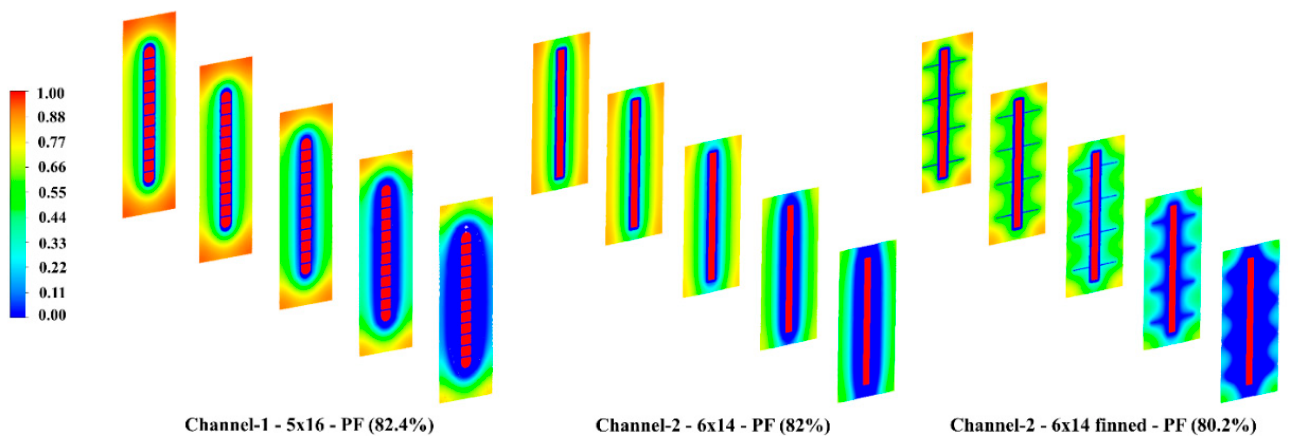
Figure 7. Melt fraction contours within solidification for the configurations of channel-1 (PF = 82.4%), channel-2 (PF = 82%) and channel-2-finned (PF = 80.2%).